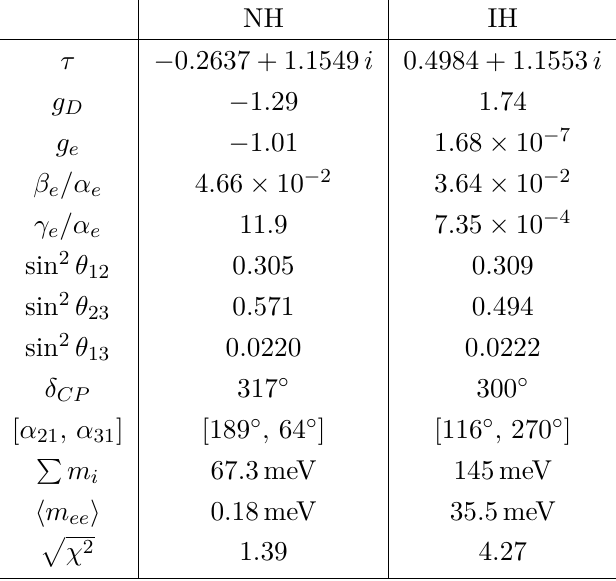
Table 3 . Numerical values of parameters and observables at the best fit points of NH and IH.